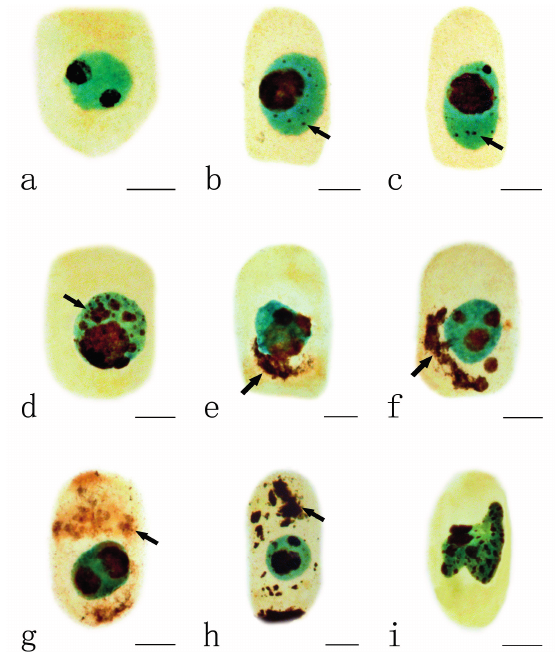
Figure 3. Effects of different concentrations of Pb on nucleoli in the root tip meristematic cells of A. cepa . ( a ) Control cell; ( b , c ) Silver-stained particles containing argyrophilic proteins in nucleus (10 μ M Pb, 48 h); ( d ) Silver-stained particles accumulated in nucleus (100 μ M Pb, 24 h); ( e , f ) Nucleolus particles extruded from the nucleus into the cytoplasm (( e ) 10 μ M Pb, 72 h; ( f ) 100 μ M Pb, 48 h); ( g , h ) Nucleolar material in the cytoplasm (( g ) 10 μ M Pb, 72 h; ( h ) 100 μ M Pb, 72 h); ( i ) Irregular nucleus (100 μ M Pb, 48 h). Scale bars = 10 μ m. Nucleoli and nucleolar material: dark brown; Nuclei: green; cytoplasm: yellow. Arrowheads show silver-stained